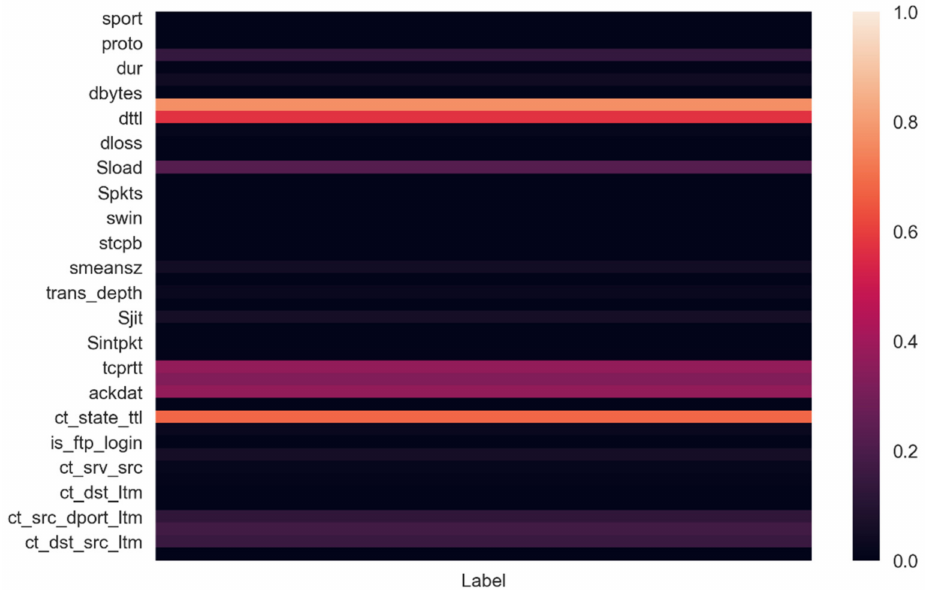
Figure 1. Correlations of the highest ranked features with output